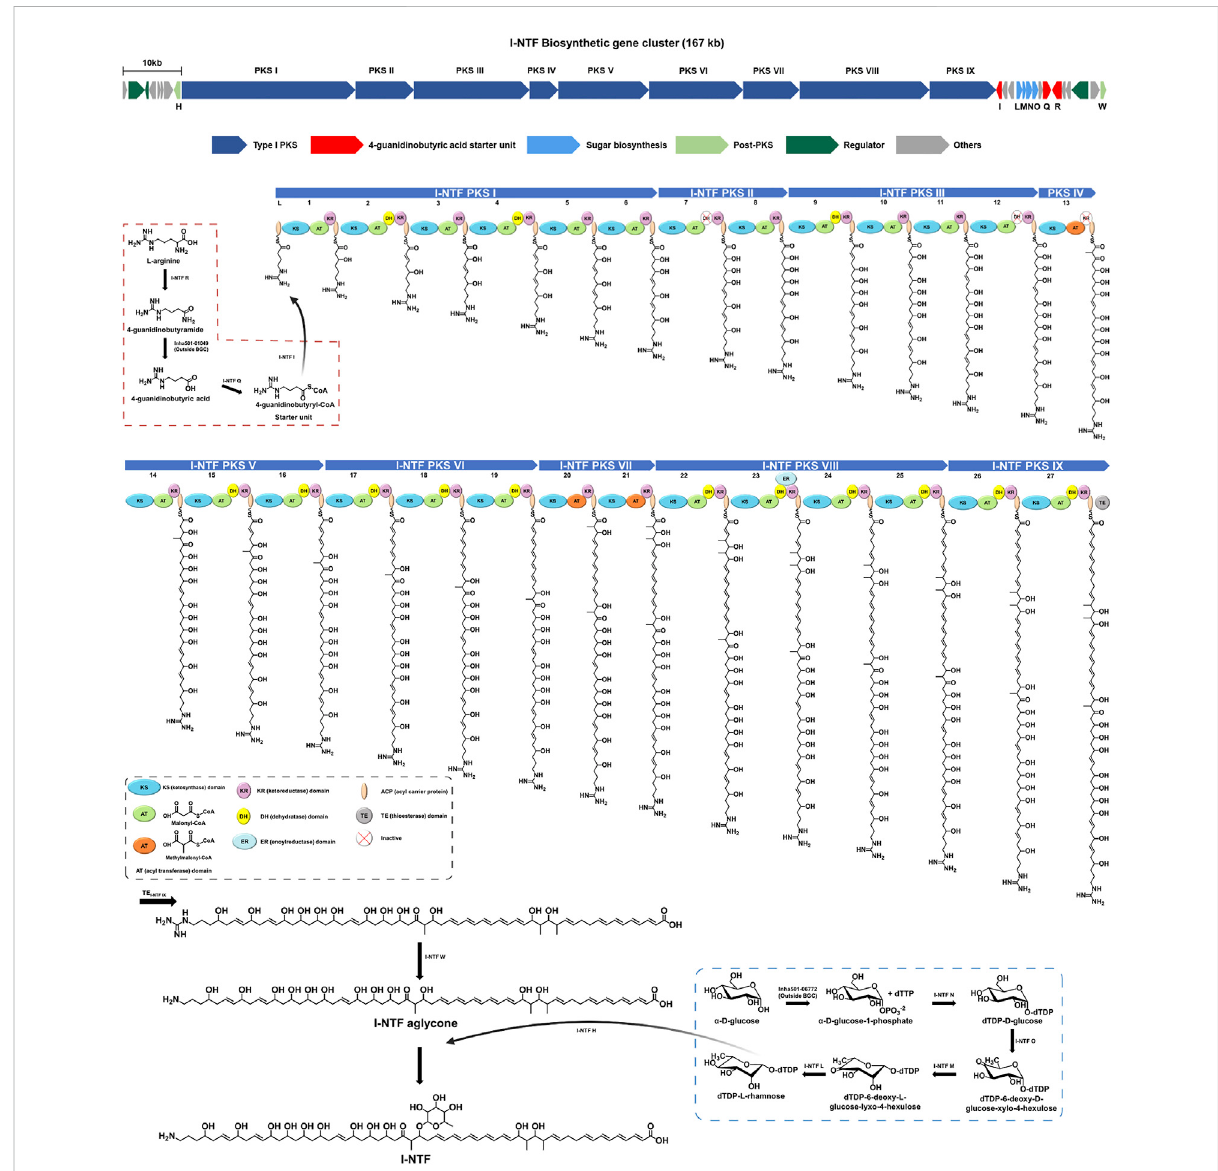
FIGURE 2 Proposedbiosynthetic pathway ofI-NTFfrom S.rubrisoli Inha501.The reddashlineisthestart unit(4-guanidinobutyricacid)synthesis, andthe blue dash line is the sugar motif (rhamnose)